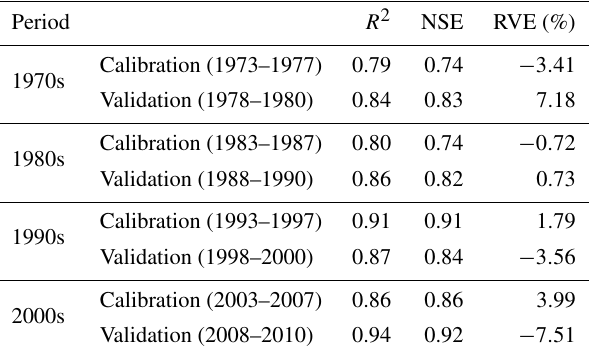
Table 5. The SWAT model’s statistical performance measure val-